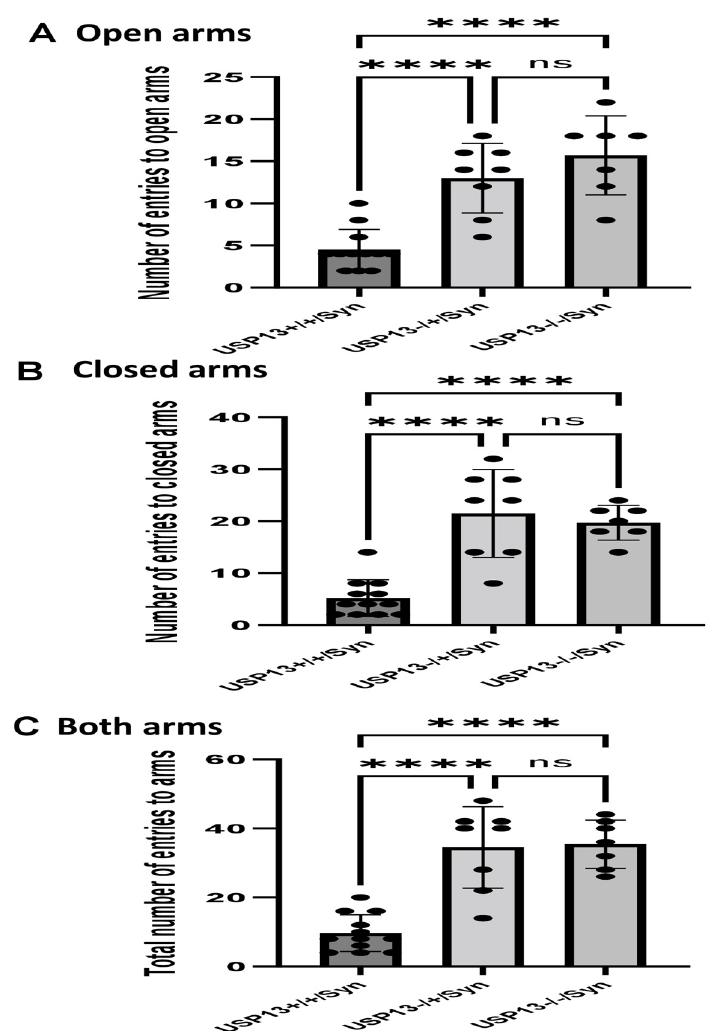
Figure 3. Human alpha-synuclein expression in SN of USP +/+ mice led to reduced motor activities in elevated plus maze test. Two weeks after human alpha-synuclein injection into right SN, elevated plus maze showed that number of entries to open arms ( A ) number of entries to closed arms ( B ) and total number of entries to arms ( C ) reduced in USP +/+ mice compared to USP +/- or USP13 -/- mice. The asterisk indicates statistically significant difference. One-way ANOVA. **** p < 0.0001. n = 7–12 per group. Mean ± SD. The black dot • represents each individual data. ns: no